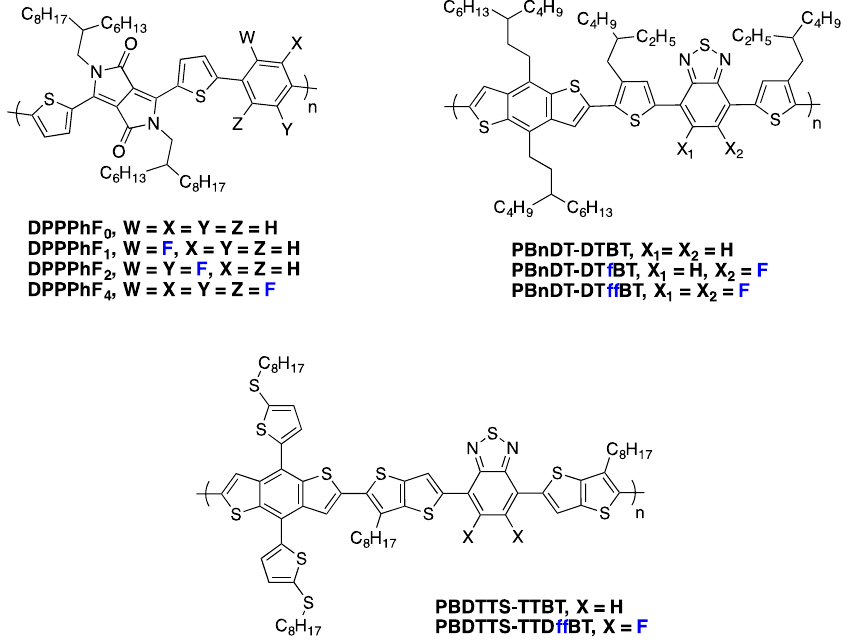
Figure 12. Chemical structures of some fluorinated polymers.